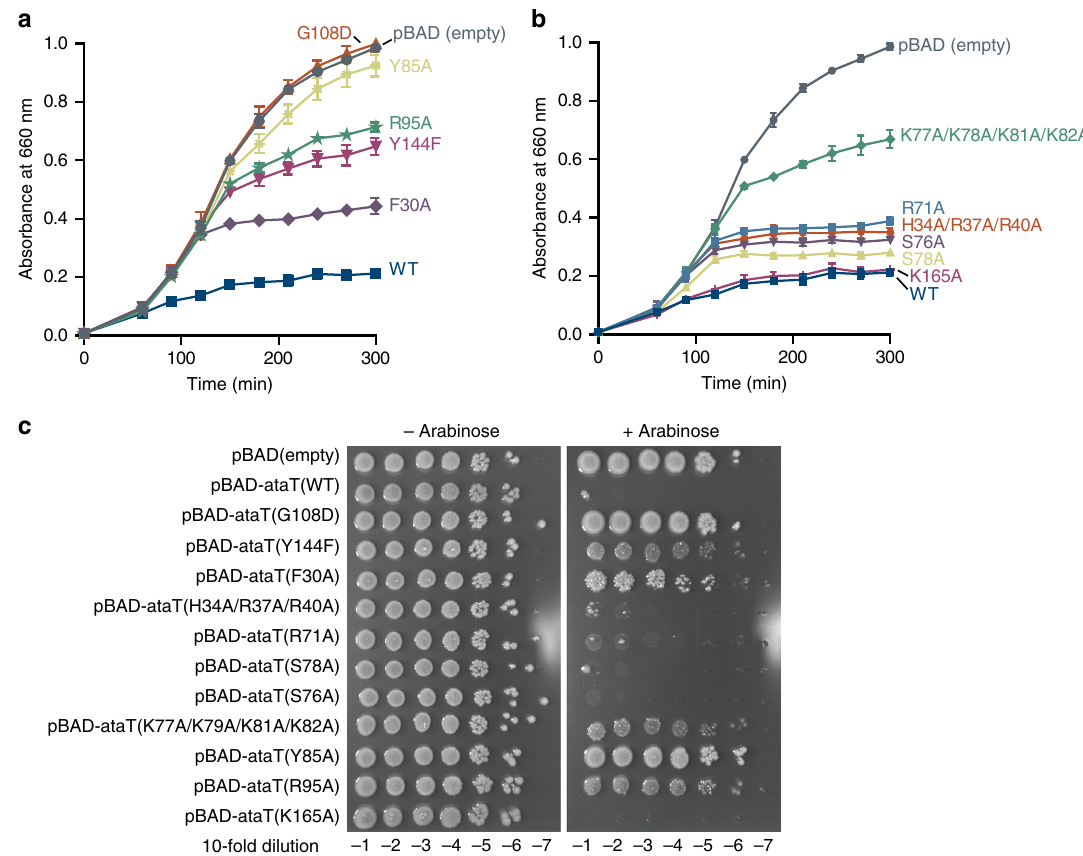
Fig. 3 Toxicity of AtaT variants. a , b Growth curves of E. coli MG1655 transformed with pBAD-ataT and its variants. E. coli MG1655 transformed by pBAD- ataT or its variants was inoculated in LB containing 50 μ g mL − 1 ampicillin and 0.2% (w/v) arabinose at 37 °C. Bars in the graphs indicate the SD of three independent experiments. c Overnight cultures of E. coli MG1655 transformed with pBAD-ataT and its variants were serially diluted, and the dilutions were spotted on LB agar plates containing 50 μ g mL − 1 ampicillin and supplemented with 0.2% (w/v) arabinose or without arabinose. The plates were incubated at 37 °C overnight. The bars in the graph are SD of three independent ( n = 3) experiments, and the data are presented as mean values ±